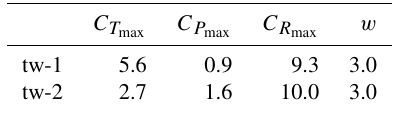
Table 3. The same as Table 2, but limiting the search domain of MINUIT only to positive lag values ( k